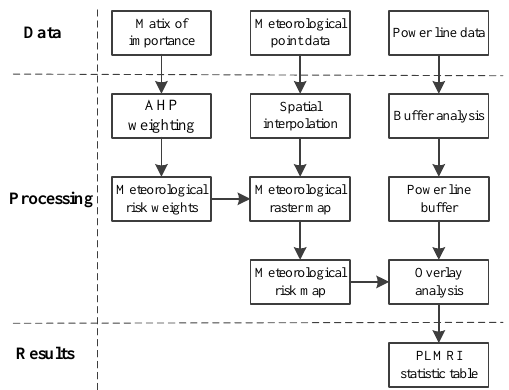
Figure 1 Framework of the meteorological risk for power